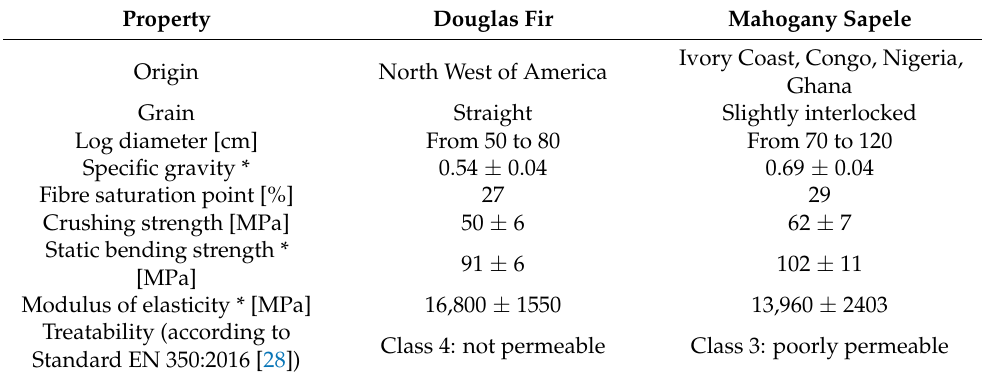
Table 1. Properties of the employed